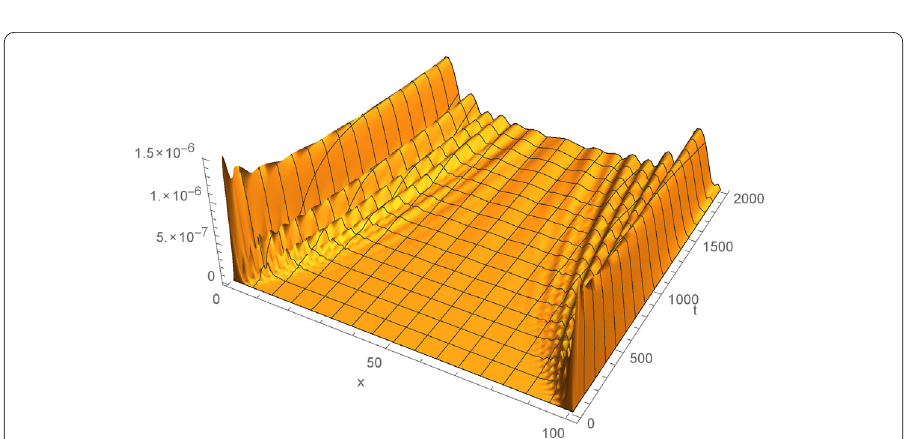
Figure 4 Absolute error for Problem 1 when N = 100, α = 1.5 and t = 1